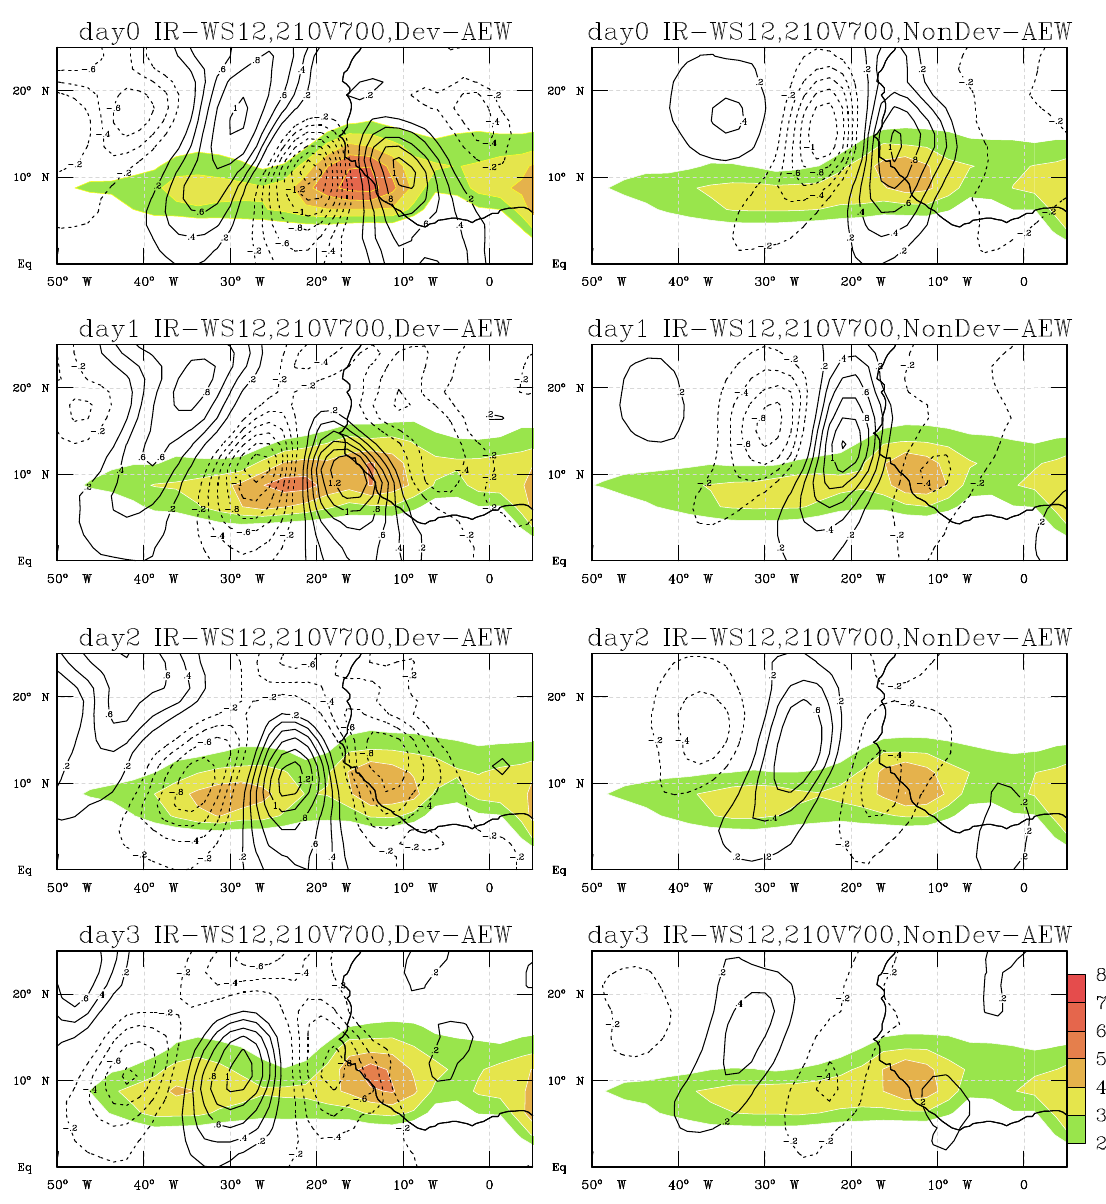
Figure 6. Composite of frequency of IR-WS12 (large-scale, well-organized deep convection) and 2–10 day filtered 700 hPa meridional wind for developing AEWs and for non-developing AEWs. IR-WS12 is shaded in color bars every 10%. Composites based on developing AEWs events are pre- sented on the left, while composites based on non-developing AEWs are on the right side. Meridional winds are contoured every 0.2 m/s.